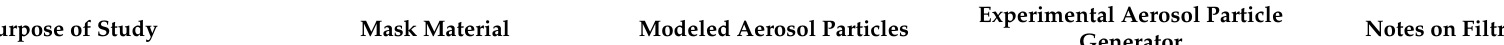
Table 2. Summary of Face Mask and Respirator Filtration Experiments and Testing Practices Using NaCl